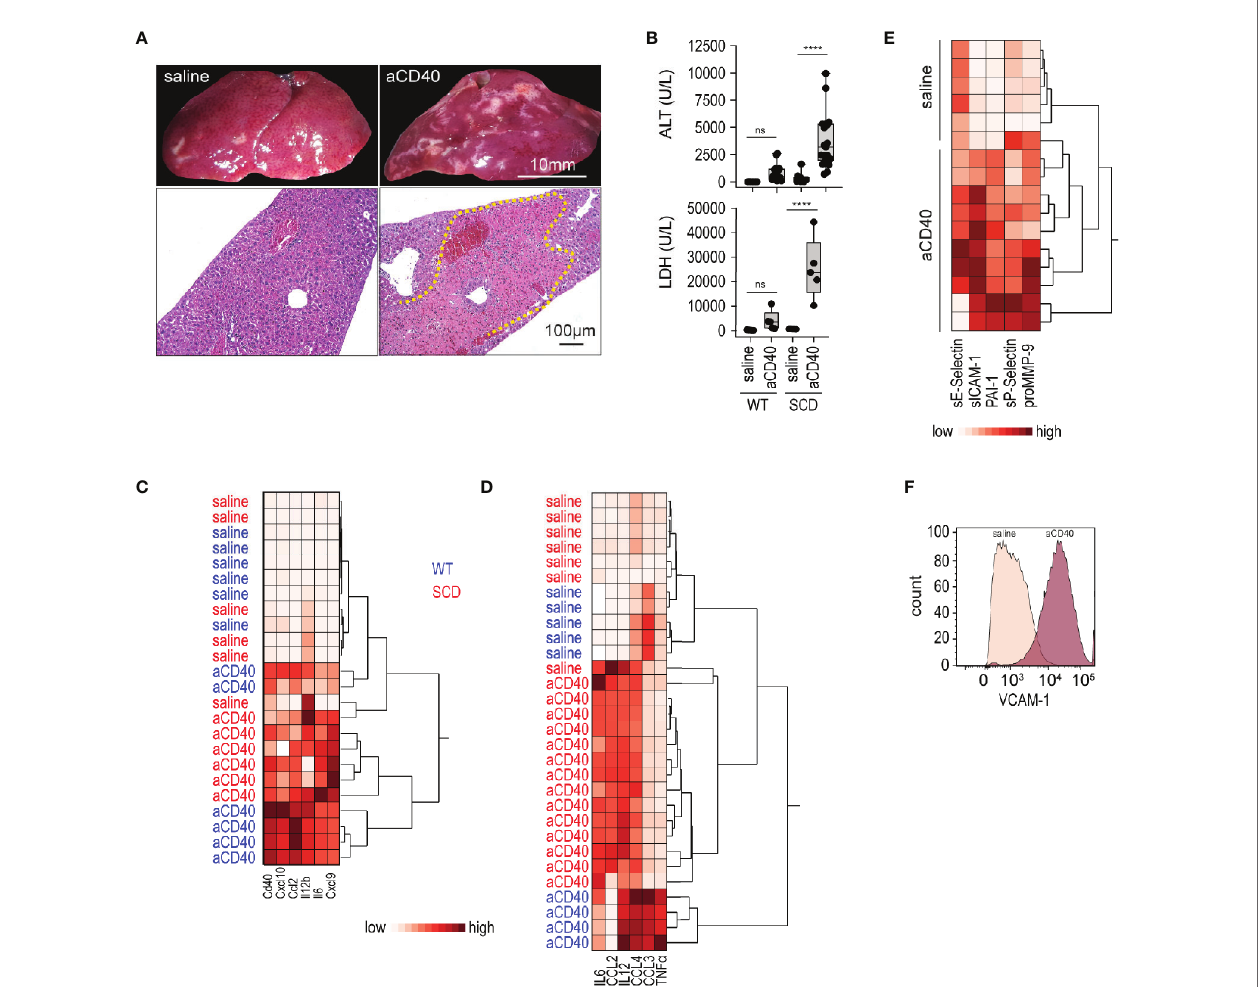
FIGURE 1 | Vaso-occlusive hepatitis and systemic in fl ammation after anti-CD40 antibody treatment in sickle cell mice. (A) Photographs of representative liver lobes (top panel) and histology image for H&E staining after treatment of sickle cell mouse with saline or anti-CD40 antibody. Images are taken 30 h after anti-CD40 antibody administration. Scale bar 10 mm and 100 µm, respectively. Dotted yellow line marks extended infarct area. (B) Plasma alanine transaminase (ALT) and lactate dehydrogenase (LDH) concentrations in heterozygote (WT) and homozygote (SCD) Berkeley mice treated with saline or anti-CD40 (aCD40) antibody (groups; for ALT WT saline n=12, WT aCD40 n=16, SCD saline n=12, SCD aCD40 n=19, for LDH n=5). (C) Hierarchical clustering analysis of the relative mRNA expression of key in fl ammatory genes measured by RT-qPCR in whole liver of WT (blue) or SCD (red) mice treated or not with anti-CD40 antibody (white=low expression, red=high expression) (n=6). (D) Hierarchical clustering analysis of plasma cytokines from saline and anti-CD40 antibody treated WT (blue) or SCD (red) mice (white=low expression, red=high expression) (groups; saline n=5 – 7, aCD40 n=4 – 14). (E) Hierarchical clustering analysis of plasma soluble adhesion molecules, plasminogen activator inhibitor 1 (PAI1), and matrix metalloproteinase-9 (pro MMP9) from saline and anti-CD40 treated sickle cell mice (white=low expression, red=high expression) (groups; saline n=6, aCD40 n=10). (F) Flow cytometry histogram of nonparenchymal liver cell suspensions gated for VCAM-1 in saline or anti-CD40 treated sickle cell mice. The displayed cells were gated from live CD45 - , CD31 + , and CD102 + cells. Data are representative of three independent experiments. Each data point represents a single mouse. **** p < 0.0001 for all panels. All comparisons between control (saline) and anti-CD40 dosed sickle cell mice were conducted by a two-tailed student ’ s t -test with signi fi cance set at a signi fi cance of p <